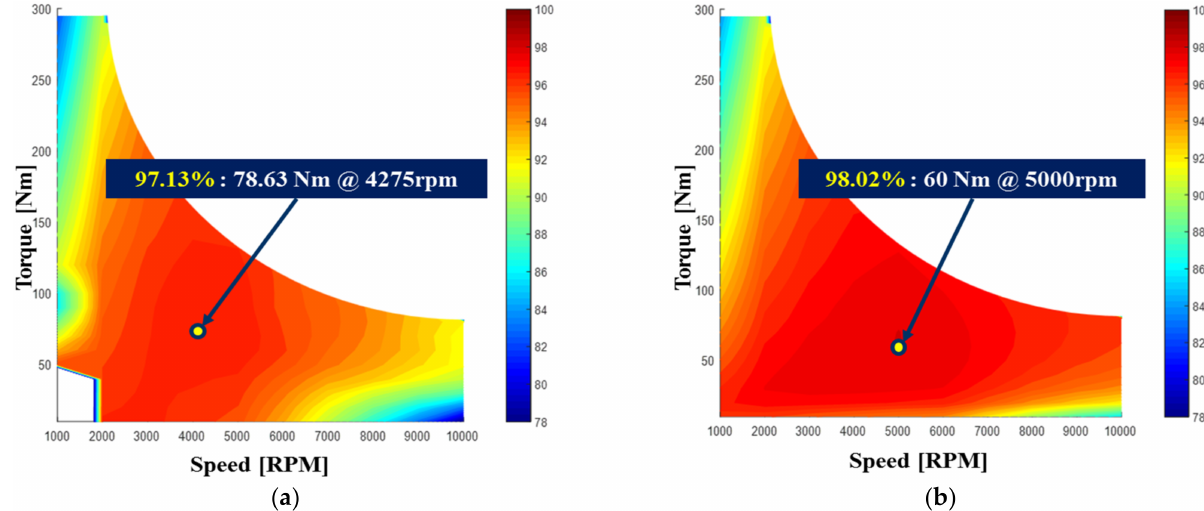
Figure 22. The comparison of the efficiency map: ( a ) experimental result; ( b ) analysis